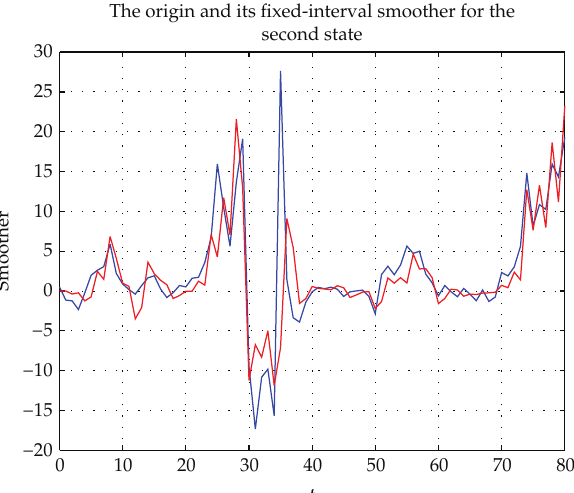
Figure 4: The origin and its fixed-interval smoother (cid:13) x 2 (cid:2) t | N (cid:3) , where the blue line is the origin signal, the red line is the smoother.